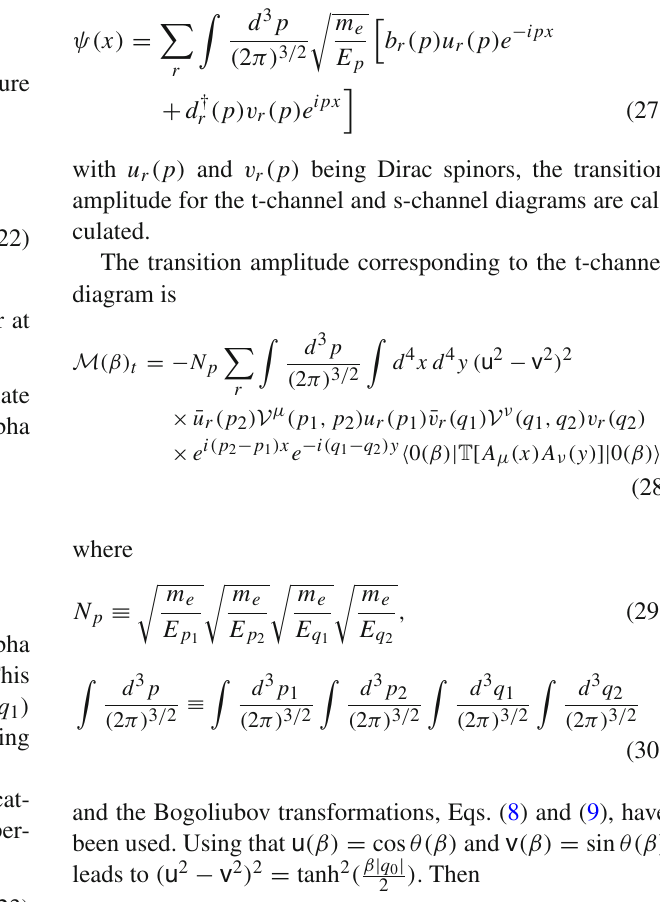
Fig. 1 Feynman diagrams to Bhabha